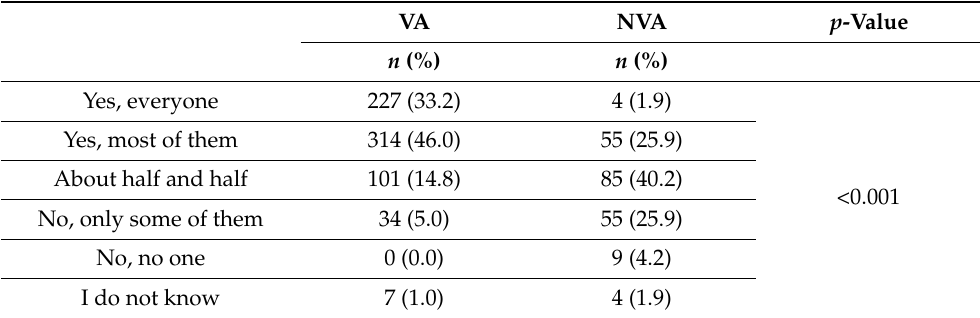
Table 4. Are your teammates vaccinated against COVID-19? Responses broken down by vaccinated (VA, n = 683) and unvaccinated (NVA, n = 212) against COVID-19. VA NVA p -Value n (%) n (%) Yes, everyone 227 (33.2) 4 (1.9) <0.001Yes, most of them 314 (46.0) 55 (25.9) About half and half 101 (14.8) 85 (40.2) No, only some of them 34 (5.0) 55 (25.9) No, no one 0 (0.0) 9 (4.2) I do not know 7 (1.0) 4 (1.9)